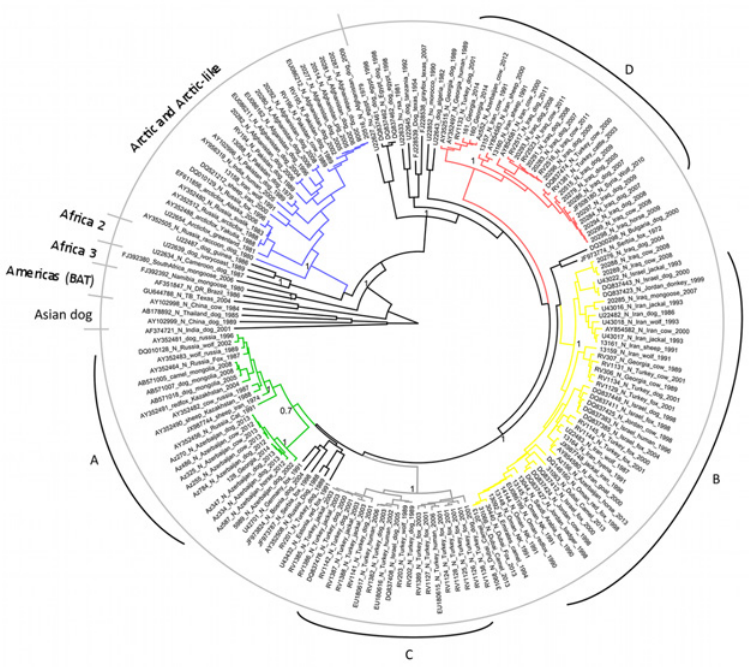
Fig 1. Maximum clade credibility tree from Bayesian reconstruction of 171 RABV partial nucleoprotein sequences, using a TN93 +G+I model of evolution with a strict molecular clock and Bayesian skyline prior, for 100 million iterations in BEAST (v1.8.0). The maximum clade credibility tree was chosen using TreeAnnotator(v1.8.0) and visualised using FigTree (v1.2). Posterior support is given at key nodes, and lineages are labelled according to previous studies [32] with the four main Middle East clades A-D labelled and coloured by region corresponding to Fig. 4.